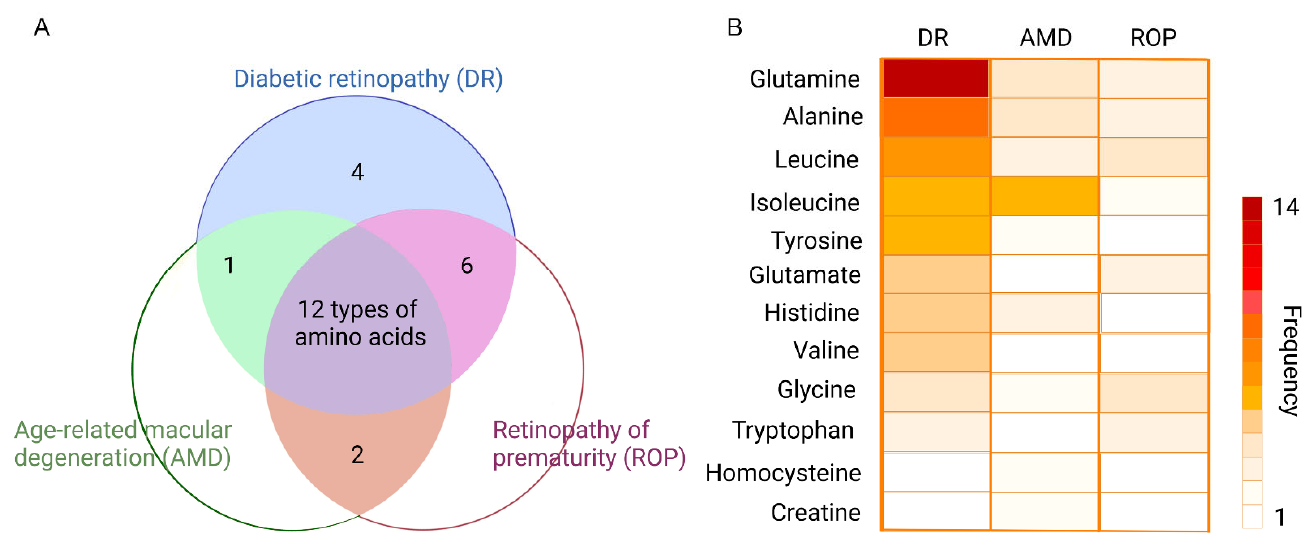
Figure 2. Top-ranking amino acids in retinopathy. ( A ) displays the Venn diagram of the differential amino acids identified in DR, AMD, and ROP, respectively. Twelve amino acids appeared in all three types of the retinopathy. ( B ) The twelve amino acids in ( A ) are collected and presented using a heatmap indicating the reported times in each disease. Accordingly, the more frequently metabolites are reported in metabolomics studies, the darker the color appears in the metabolite zone.